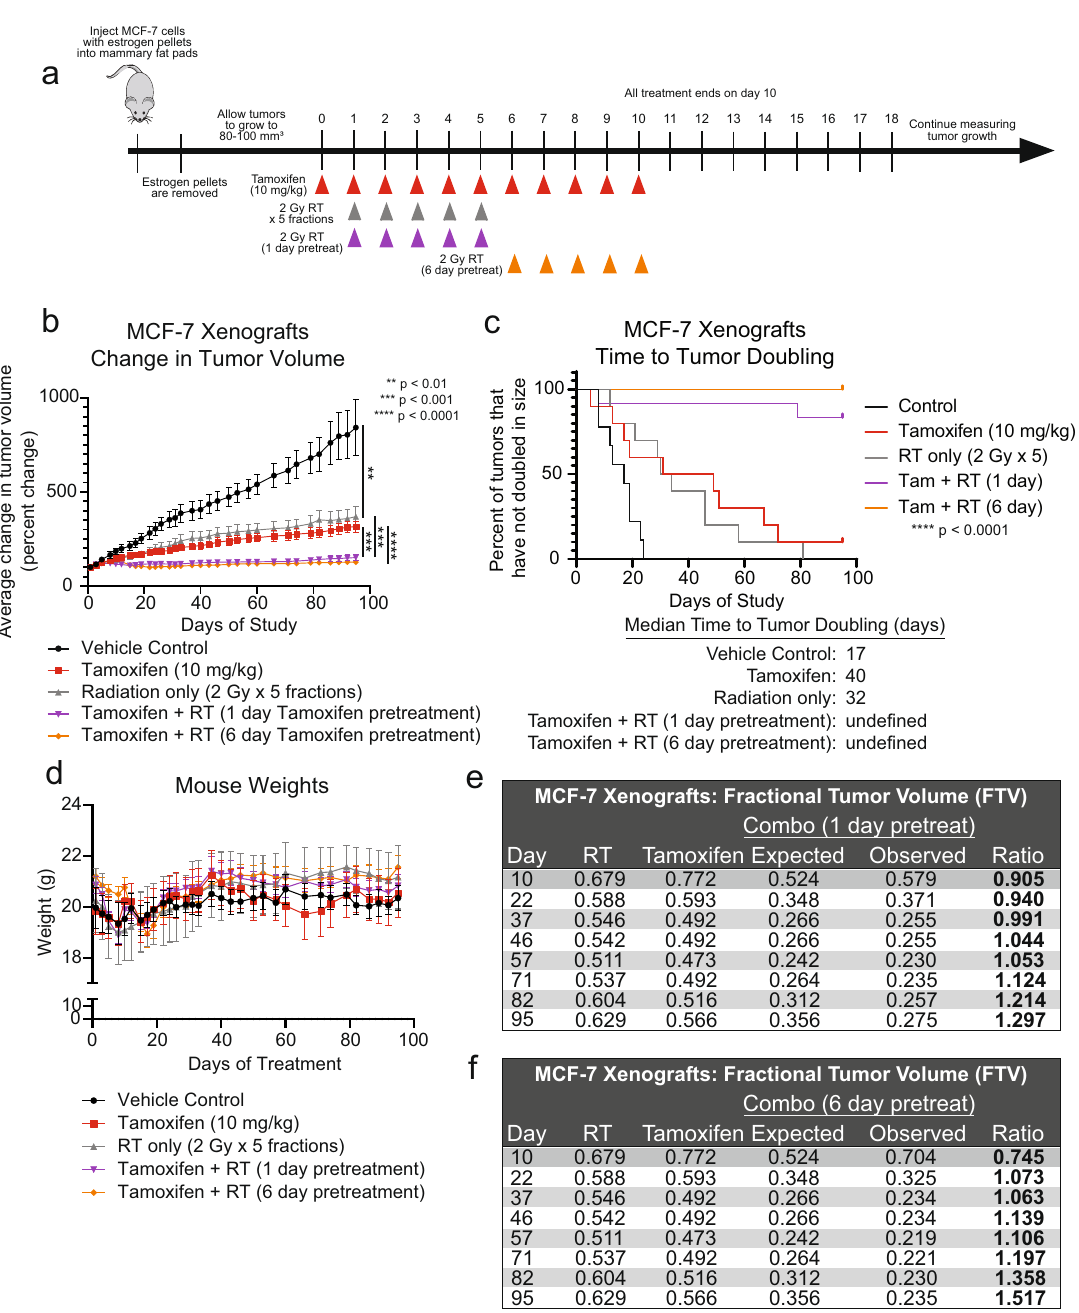
Fig. 5 Tamoxifen in combination with radiation is more effective than radiation alone in an MCF-7 xenograft model. MCF-7 cells were injected into the mammary fat pads of CB17-SCID mice, and treatment was initiated when tumors were 80 – 100 mm 3 . Mice treated with the combination of tamoxifen and radiation received tamoxifen for 1 or 6 days prior to the start of radiotherapy ( a ). The average change in tumor volume was recorded for each treatment condition ( b ). Time to tumor doubling was assessed for each treatment ( c ). The combination treatment did not have signi fi cant toxicity as there were no changes in mouse weights ( d ). Tamoxifen with radiation was found to be synergistic using the fractional tumor volume method in which ratios >1 indicate synergy ( e , f ). Data are graphed as mean ± SEM. (** P < 0.01, *** P < 0.001, **** P < 0.0001). monolayers; however, cells grown in estrogen-free media had a has been inconclusive in determining the optimal timing of signi fi cant decrease in radiosensitivity compared to cells treated administration of ET and RT for patients. In one study, rats with with 17 β -estradiol 41 . Treatment with the aromatase inhibitor, mammary tumors induced by 1-methyl-1-nitrosourea (MNU) bene fi ted from the treatment of tamoxifen or RT alone, while letrozole, also had radiosensitizing effects on MCF-7 cells in vitro 42 . receiving similar levels of bene fi t from the combination treatment In a contrasting study, a decrease in radiosensitivity was observed with no signi fi cant radiosensitization noted 40 . Other studies using by Wazer et al. when treating MCF-7 cells with tamoxifen in combination with RT compared to treatment with RT alone when MCF-7 cells grown in spheroids with estrogen supplementation tamoxifen was given 48 h prior to RT 43 . These fi ndings are had little change in radiosensitization compared to cells grown in Published in partnership with the Breast Cancer Research